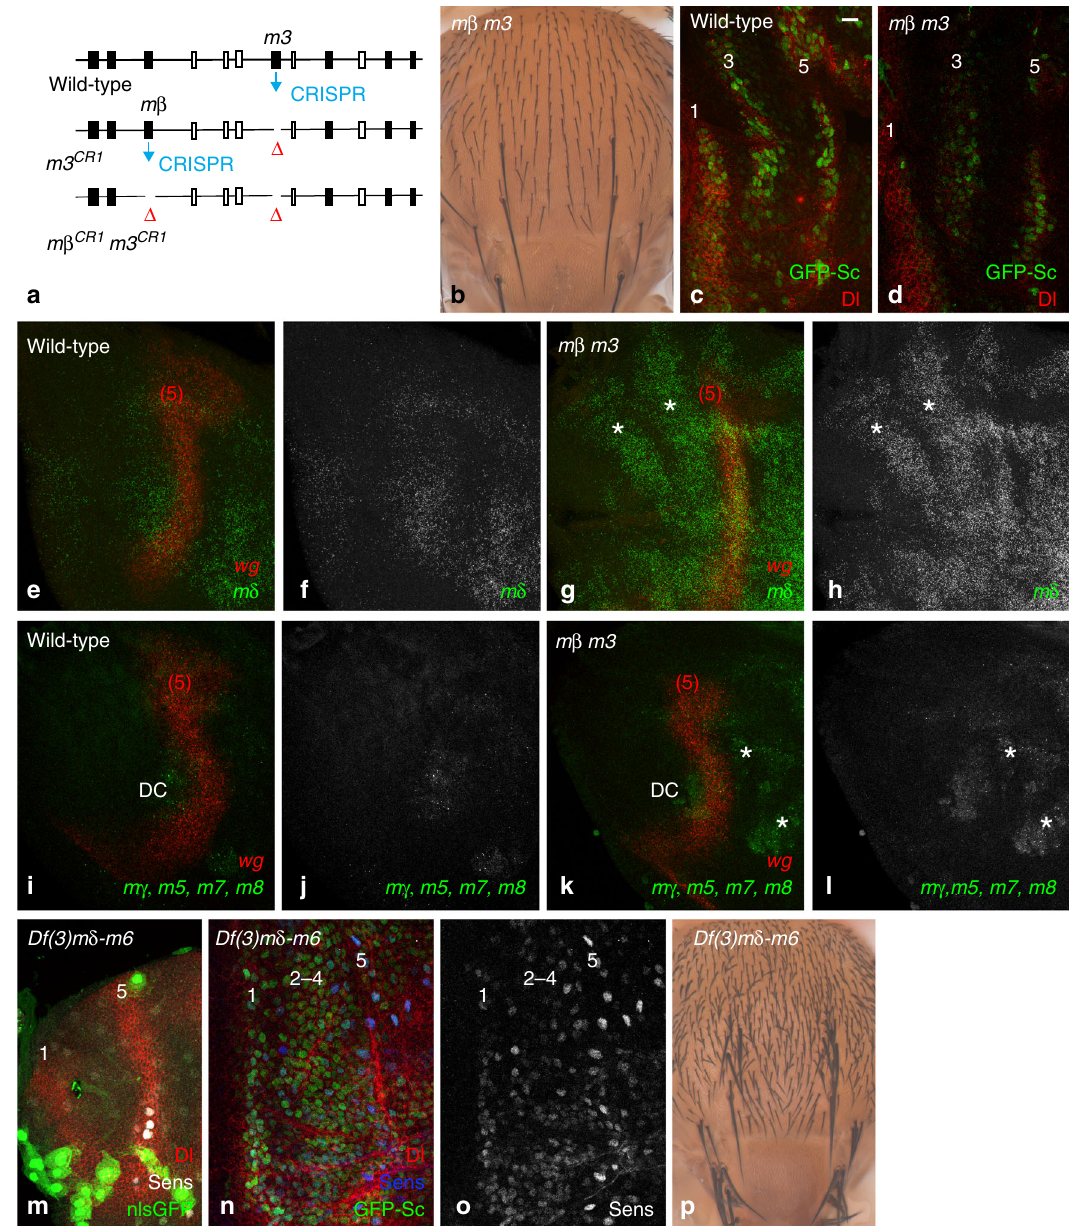
Fig. 5 E(spl)-HLH genes are required for stripe patterning. a A two-step CRISPR-based deletion of the m3 and m β ORFs to rpoduce a double mutant chromosome. b Dorsal thorax of an adult m3 m β / Df(3)X10 fl y showing no bristle patterning defect. The X10 deletion removes the m δ -m3 genes